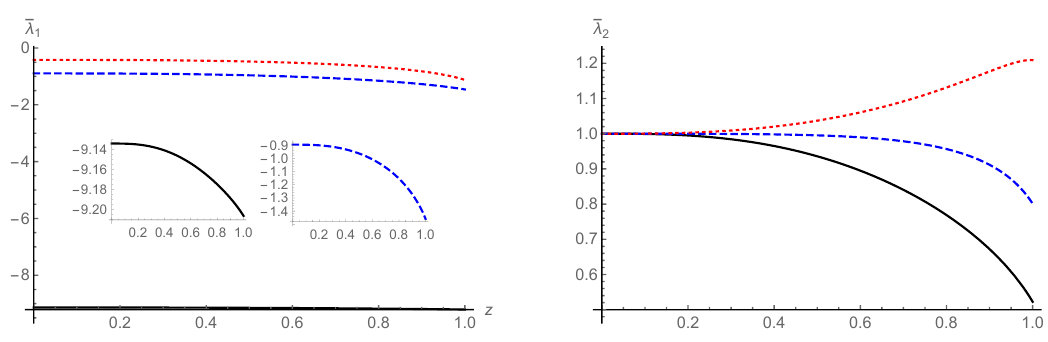
p 2 = 2 (blue-dashed) , 0 : 9